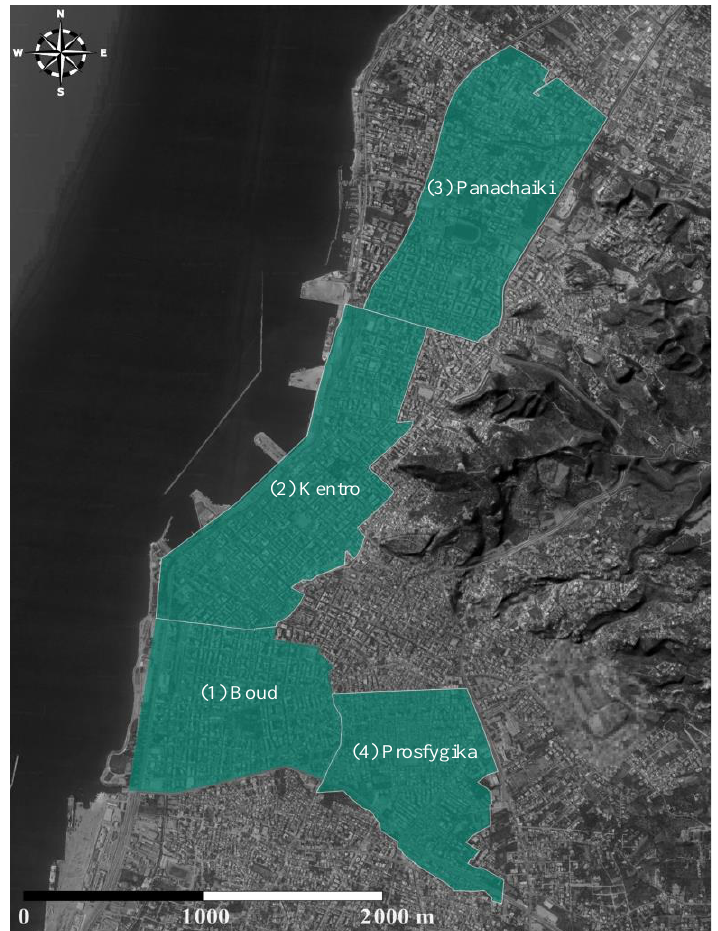
Figure 1. Map indicating the locations of the four largest PMAs of the city of Patras in western Greece. Numbers correspond to the entries in Table 1.